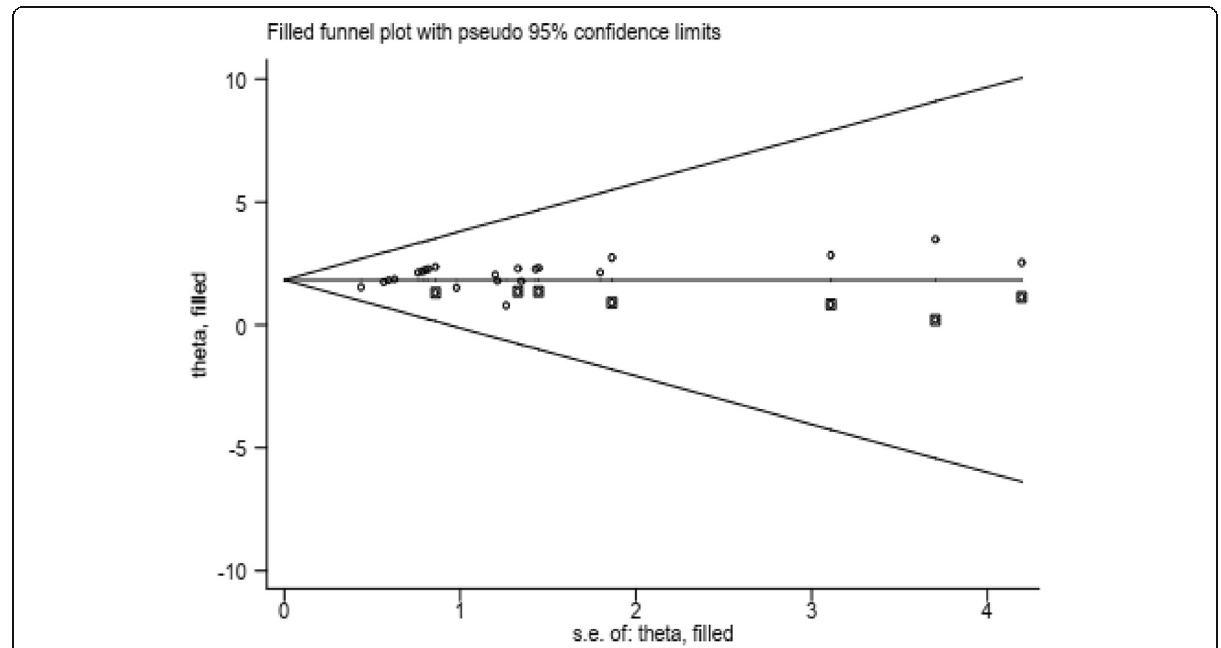
Fig. 2 Frim-trill analysis result of 33 included studies for vertical HIV infection in East Africa,